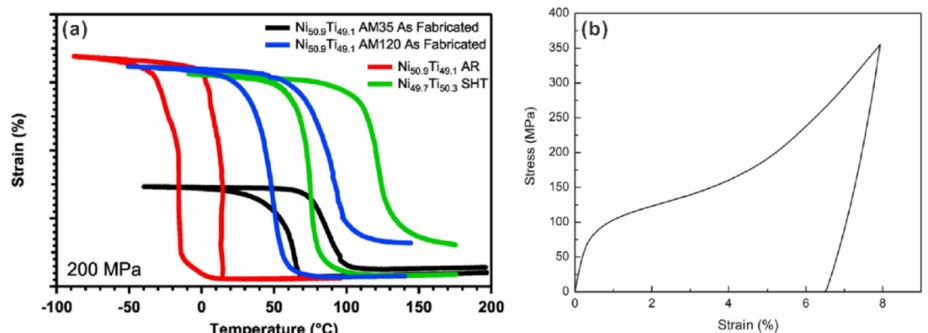
Figure 5. ( a ) Isobaric heating-cooling curves of a Ni 50.9 Ti 49.1 alloy fabricated with a small hatch spacing of 35 µ m (black curve), and a large hatch spacing of 120 µ m (blue curve). For both samples, the laser power (50 W), scanning sapped (80 mm s − 1 ), and layer thickness (30 µ m) were the same. The results of the conventionally fabricated Ni 50.9 Ti 49.1 (red curve) and a Ni 49.7 Ti 50.3 alloy after solution treatment (900 ◦ C, 1 h, green curve) are also shown [56] (with permission from Elsevier Publisher); ( b ) Stress-strain curve of a NiTi ribbon fabricated by repetitive laser scan. A laser power of 25 W was used for the first scan, and the laser power of 60 W was used for the second scan [100] (with permission from Springer